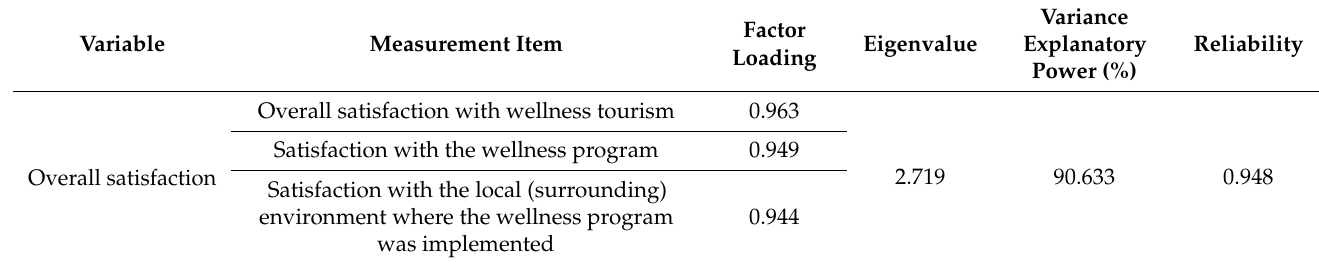
Table 7. Results of factor analysis of overall satisfaction with wellness tourism product measure- ment items.